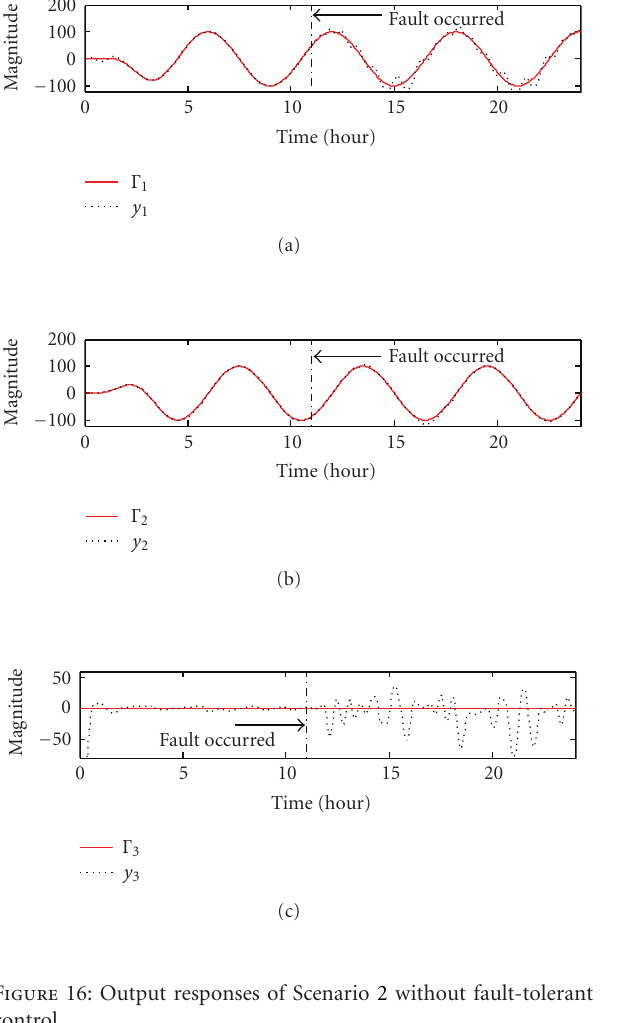
Figure 16: Output responses of Scenario 2 without fault-tolerant control.